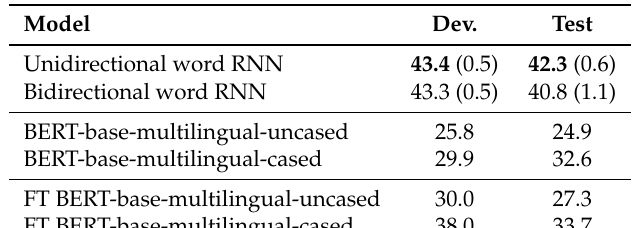
Table 11. Accuracy results (%) for the TOPIK set. We report the average accuracy with the standard deviation if a model was optimized repeatedly. For the fine-tuned (FT) models, the held-out accuracies are presented in Dev. column.